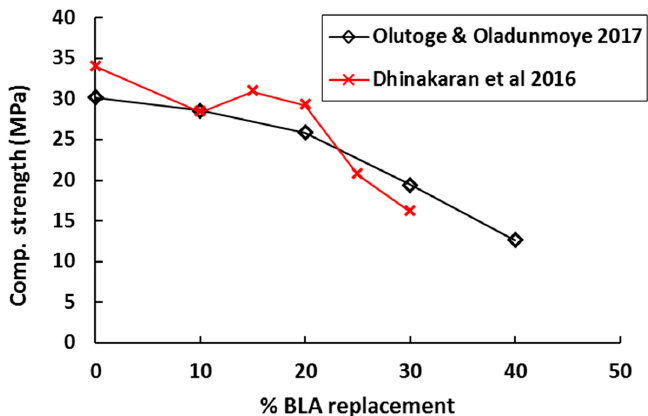
Figure 14. Influence of bamboo leaf ash replacement on the setting time of concrete [116,117] .